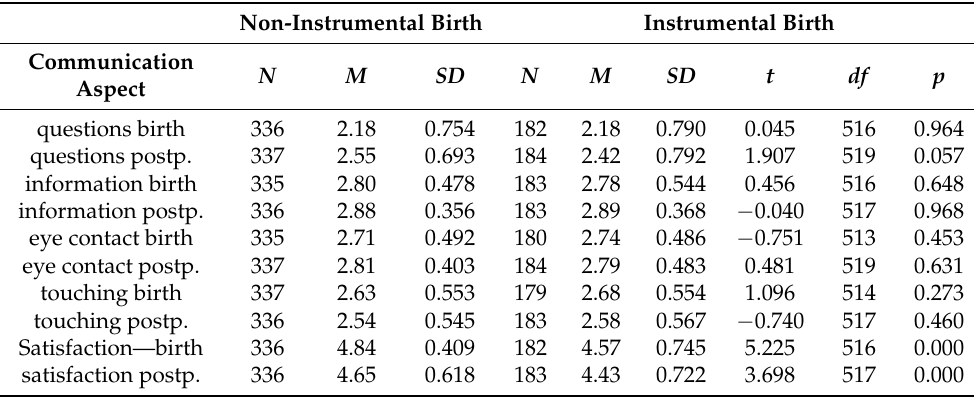
Table 2. Descriptive statistics and results of the independent t -test analysis of communication needs and communication satisfaction during and after instrumental and non-instrumental